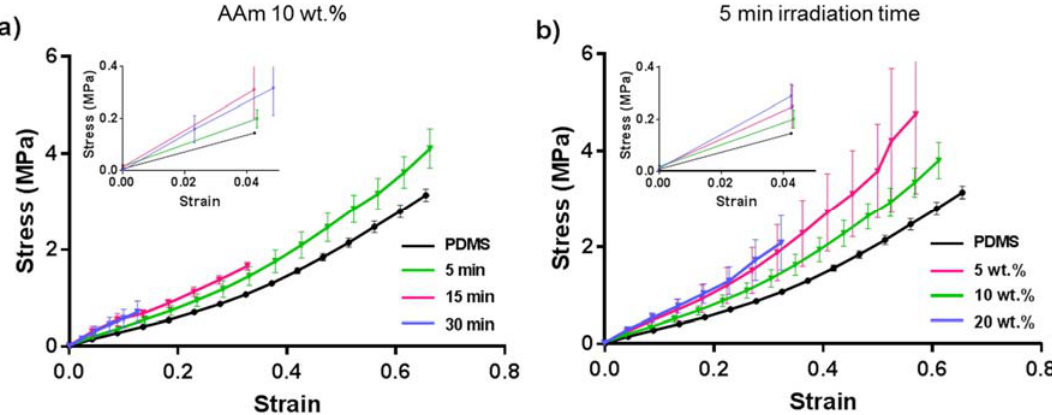
Figure 8. Stress-strain diagram of ( a ) PDMS and PDMS coated with 10 wt % acrylamide irradiated for different UV radiation time, ( b ) PDMS and PDMS coated with acrylamide of different concentrations after 5 min UV radiation.